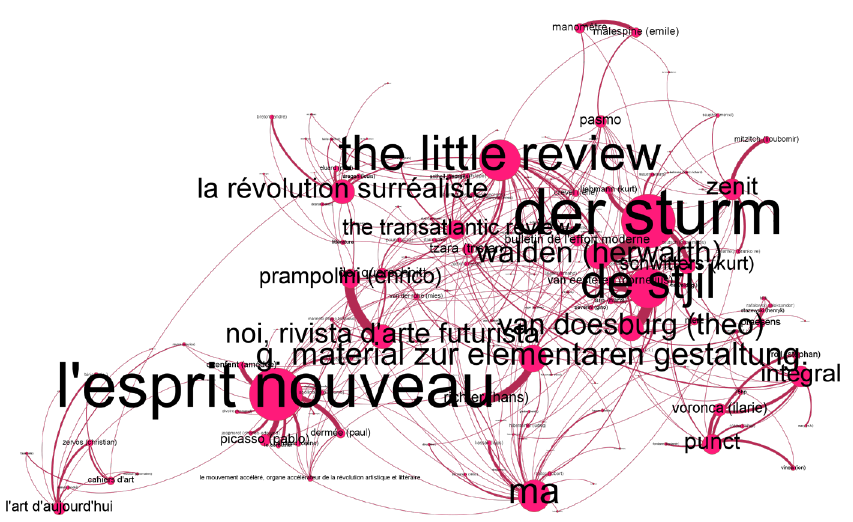
Fig. 4 Network Analysis of the content of 25 modernist magazines from 1924 to 1926. Sharing Names (artists illustrated, and authors of the articles published). Sources: see note